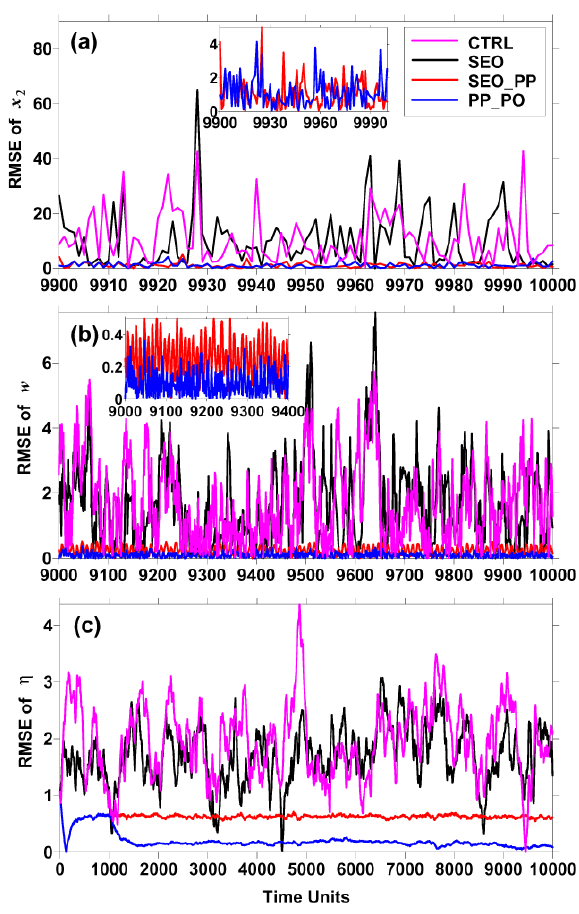
Fig. 4. Time series of RMSEs of (a) x 2 in the last 100TUs, (b) w in the last 10 3 TUs, and (c) η in 10 4 TUs in CTRL (pink line), SEO (black line), SEO_PP (red line), and PP_PO (blue line). Small pan- els in (a) and (b) show the detailed evolutions of RMSEs of x 2 and w in SEO_PP (red line) and PP_PO (blue line) through enlarging the scale of the vertical